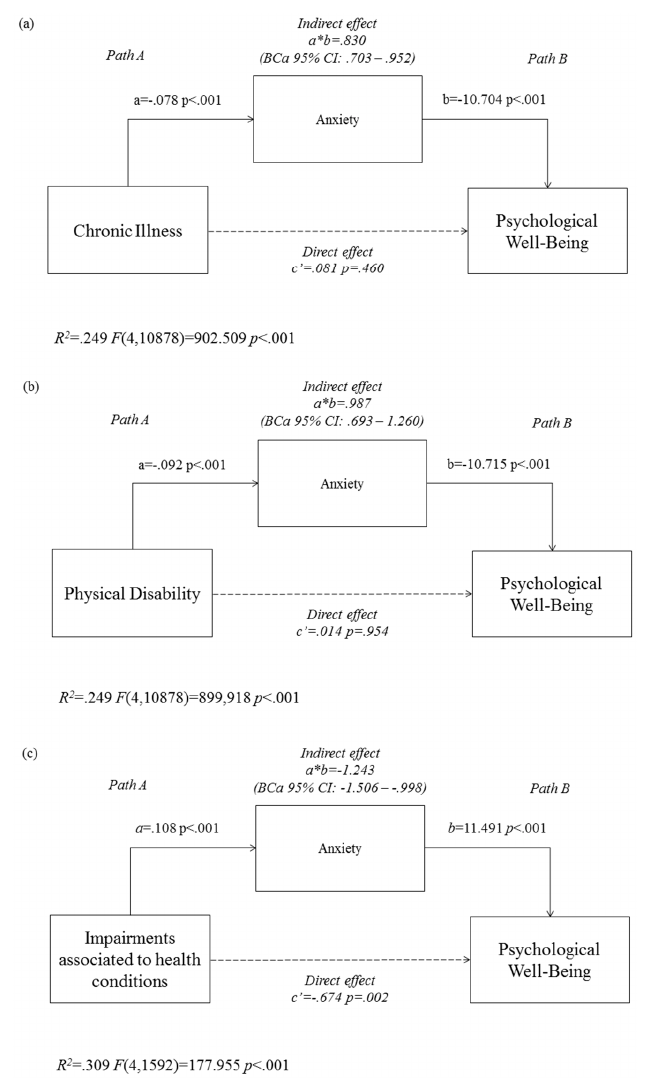
Figure 1. Indirect effects of having a chronic illness ( a ), having a physical disability ( b ), as well as having impairments associated with these health conditions ( c ), on subjective well-being (WBI-5 scores), as mediated by anxiety (SAS scores) (unstandardized regression coefficients). Note. SAS: Zung Self Rating Anxiety Scale. WBI-5: WHO-5 Well-being Index. BCa 95% CI : bias corrected and accelerated 95% Confidence Interval. Number of Bootstrap Resample: 1000.